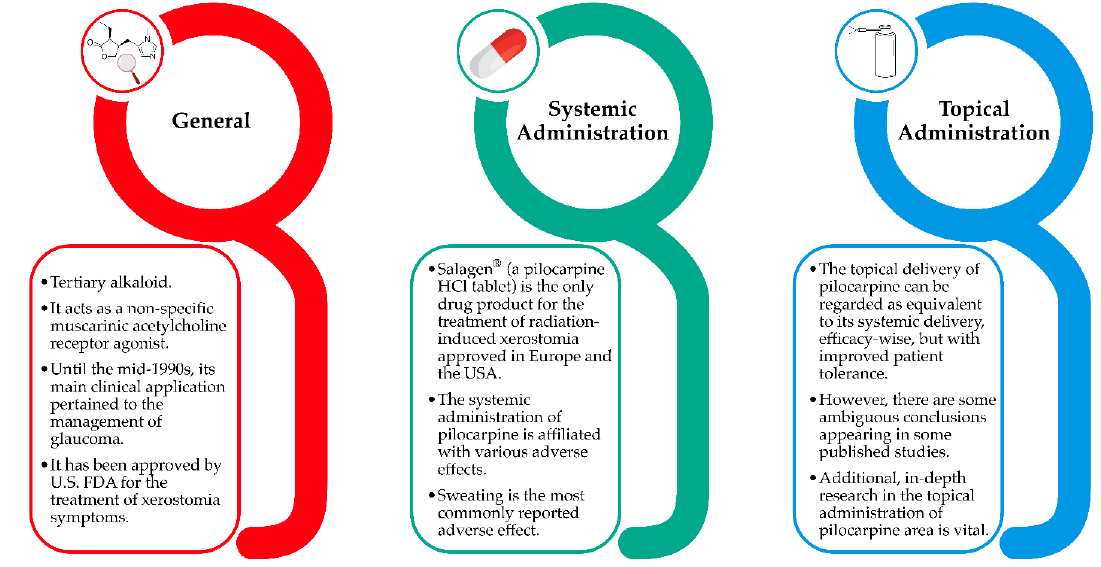
Figure 7. The most important points of pilocarpine’s administration.